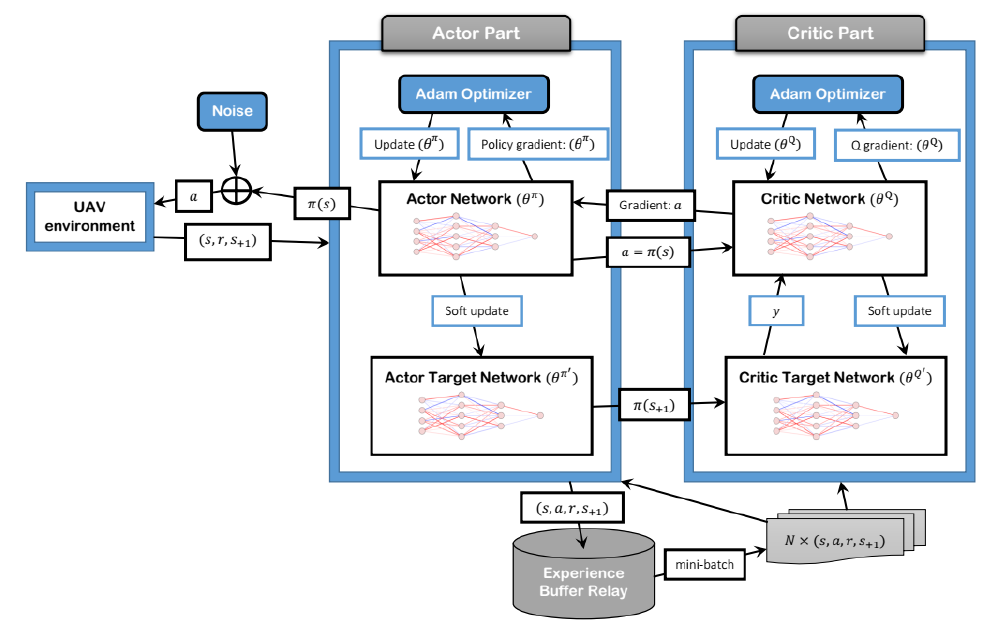
Figure 2. Actor–critic network.